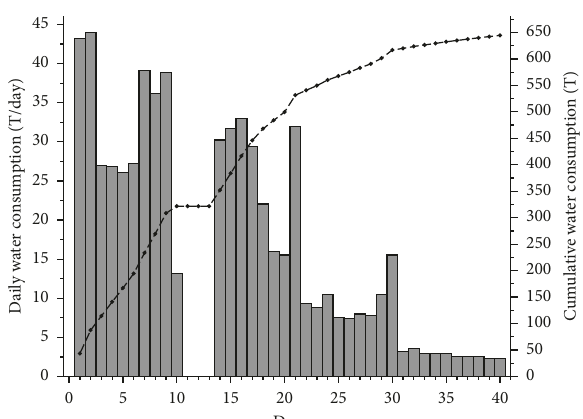
Figure 5: The daily and cumulative water consumption in 40-day irrigation experiments in Jinya Town. It should be noted that the irrigation process was interrupted for three days from the 11th to the 14th day due to equipment reasons.